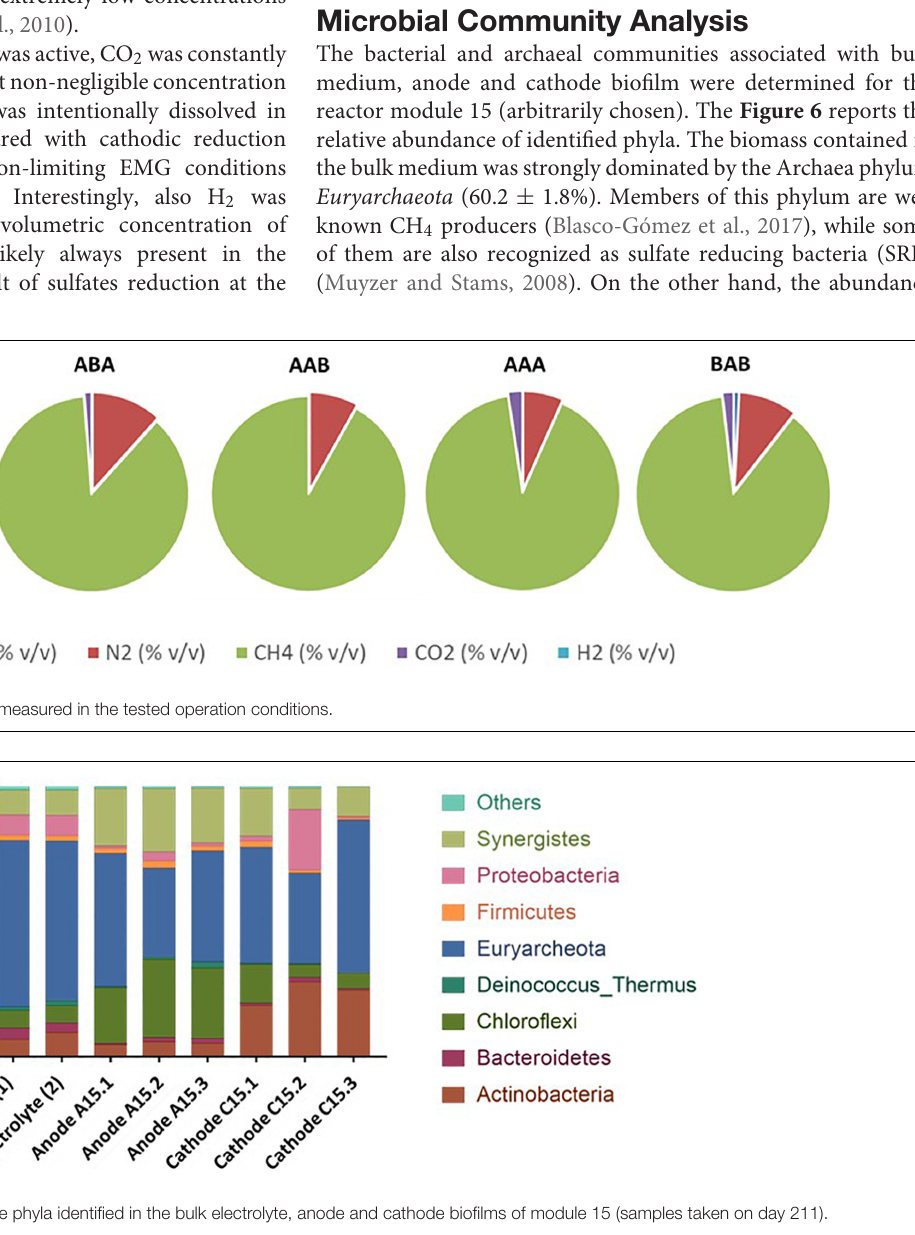
Frontiers in Energy Research |